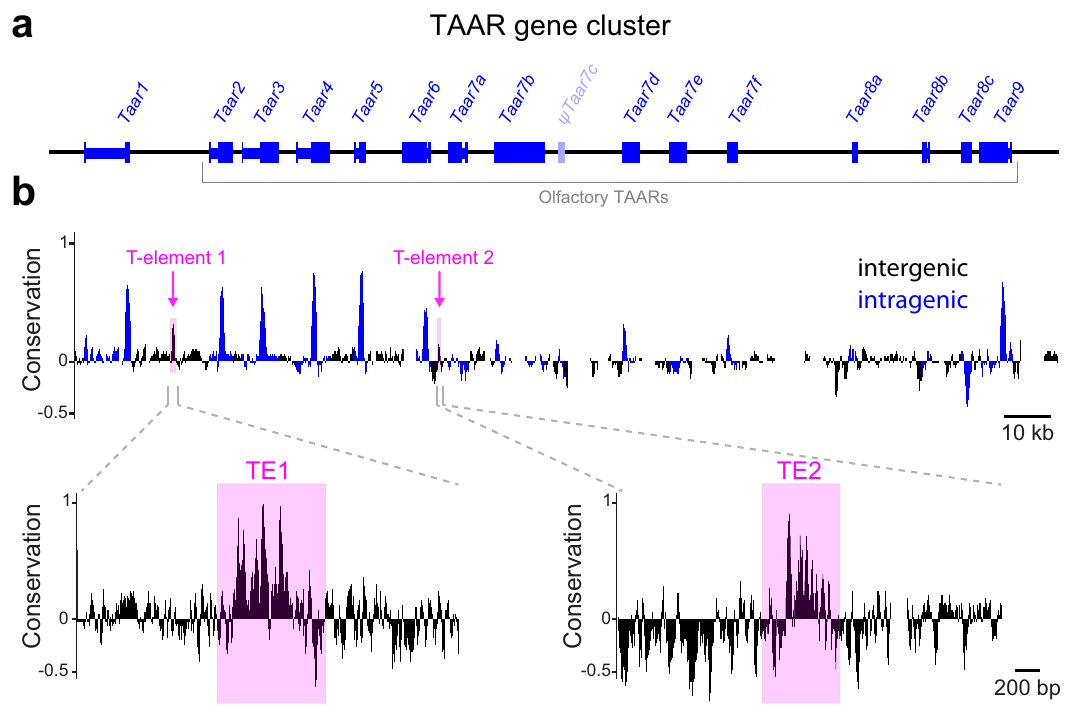
Fig. 2 Identi fi cation of putative enhancers in the TAAR cluster. a Gene structure of all 15 intact TAARs (blue) and the pseudogene ψ Taar7c (light blue). Exons (thick lines) and introns (thin lines) are indicated. b Basewise conservation across eutherian mammals in the TAAR cluster determined using PhyloP. Regions within known genes are shown in blue, intergenic regions in black. Two intergenic regions that have high conservation peaks and HD sequences (TE1 and TE2) are highlighted (magenta). Conservation track is expanded